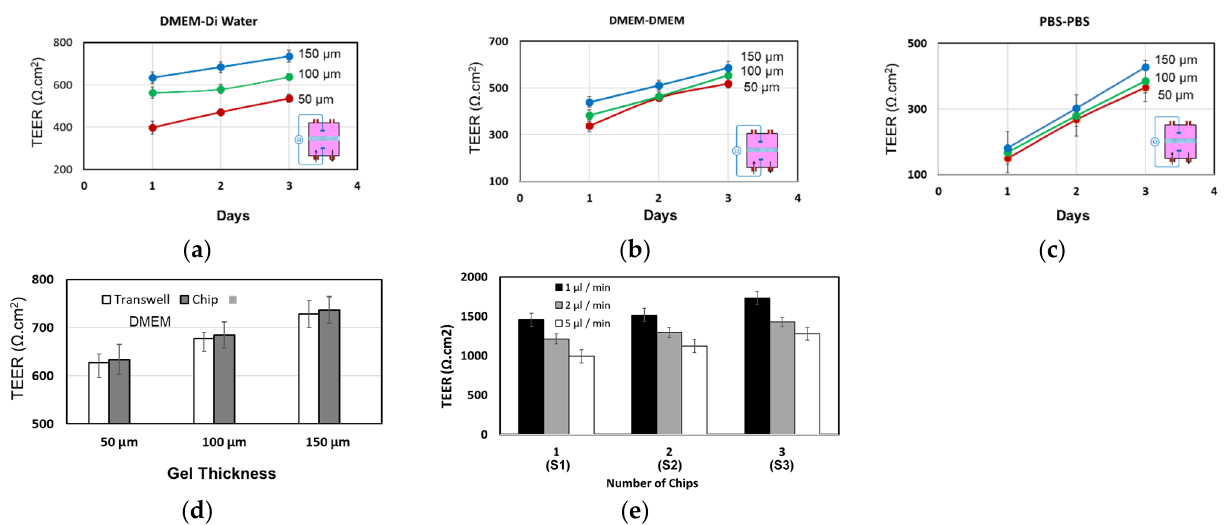
Figure 4. ( a – c ) The TEER values of the artificial agarose-coated membrane with three different thicknesses (50 μ m, 100 μ m and 150 μ m) measured in individual microfluidic chips at a flow rate of 5 μ L/min. ( d ) The measured TEER values within the chip were higher than those in the transwell with the same gel thicknesses. Flow rate in the chip was 5 μ L/min. ( e ) TEER values measured across two membranes within two chips which are connected through the lower compartments.